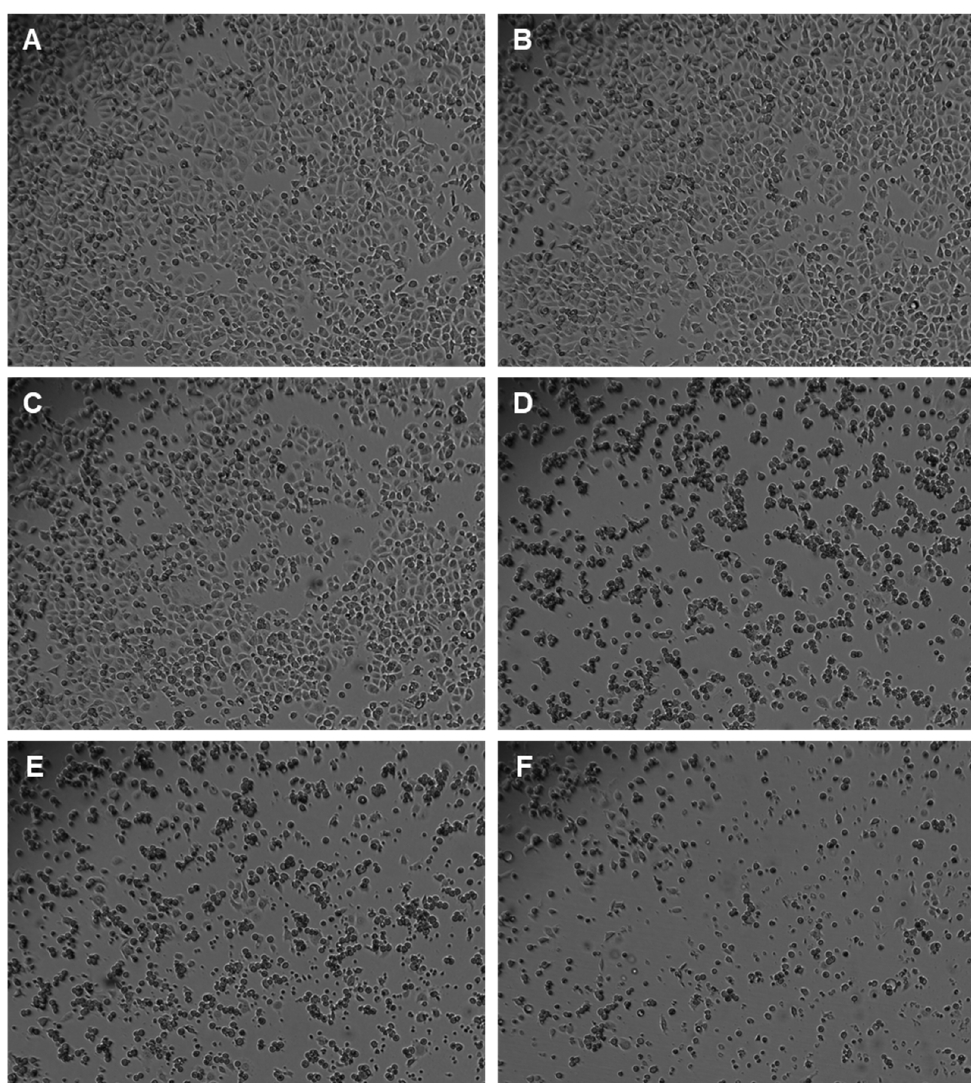
Figure 5. Effects of PTX on the morphology of MCF-7 cells. Cells were treated with ( A ) vehicle (DMSO), ( B ) 0.1 nM, ( C ) 1 nM, ( D ) 10 nM, ( E ) 100 nM, and ( F ) 500 nM PTX. Representative images were obtained with a high contrast brightfield objective (10×) (LionHeart FX Automated Microscope), from three independent experiments.